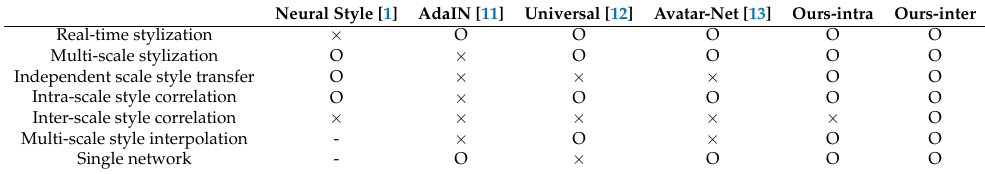
Table 4. Characteristics of the image style transfer